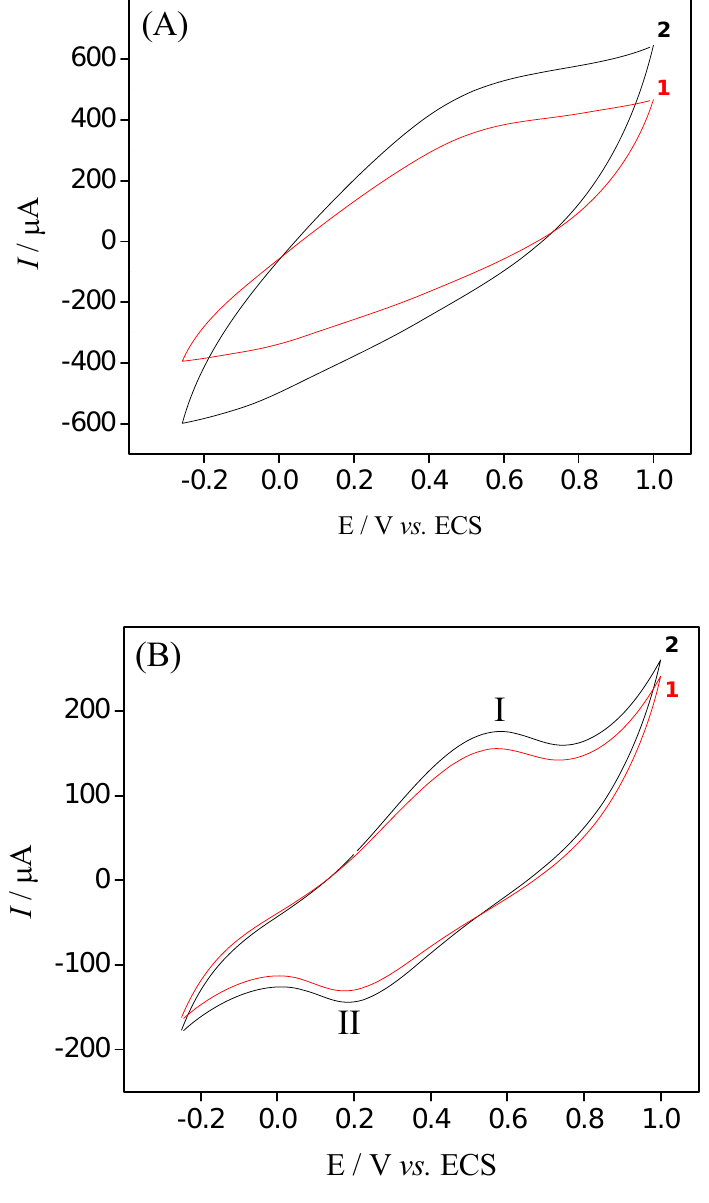
Figure 2. Cyclic voltammograms obtained at a scan of 50 mV s − 1 for carbon paste modified with 20% (m/m) hollandite-type MnO : (1 – red curve) in TRIS buffer solution 2 (pH = 8); (2 – black curve) in TRIS buffer solution containing 4.8 × 10 − 4 mol L − 1 of potassium ions . Hollandite manganese oxide synthesized by (A) redox precipitation; (B) sol-gel